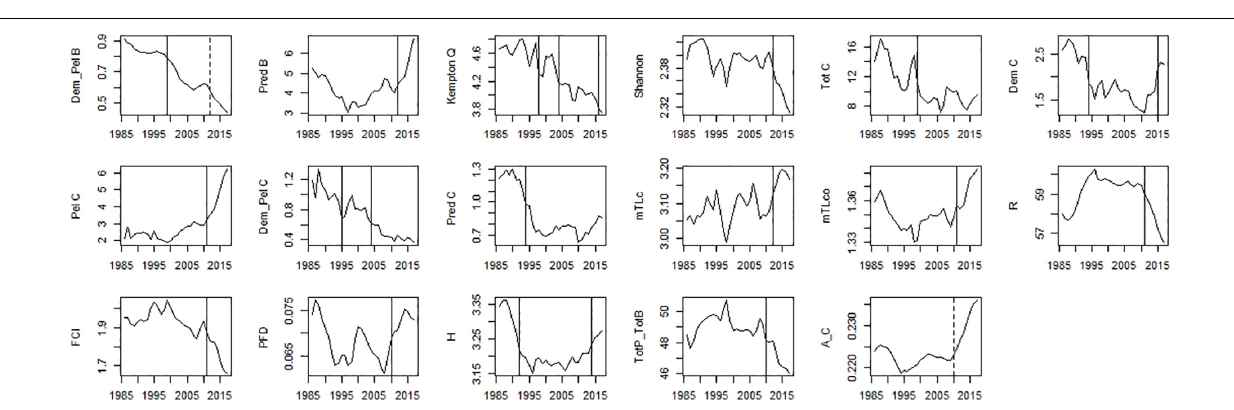
FIGURE 8 | Time-series of ecosystem indicators data. Significant shifts detected by STARS analysis are displayed on the plots as solid and dashed vertical line for shifts significant at p ≤ 0.05 and ≤ 0.1, respectively. Abbreviations, used in the figure, are explained in Supplementary Table 4